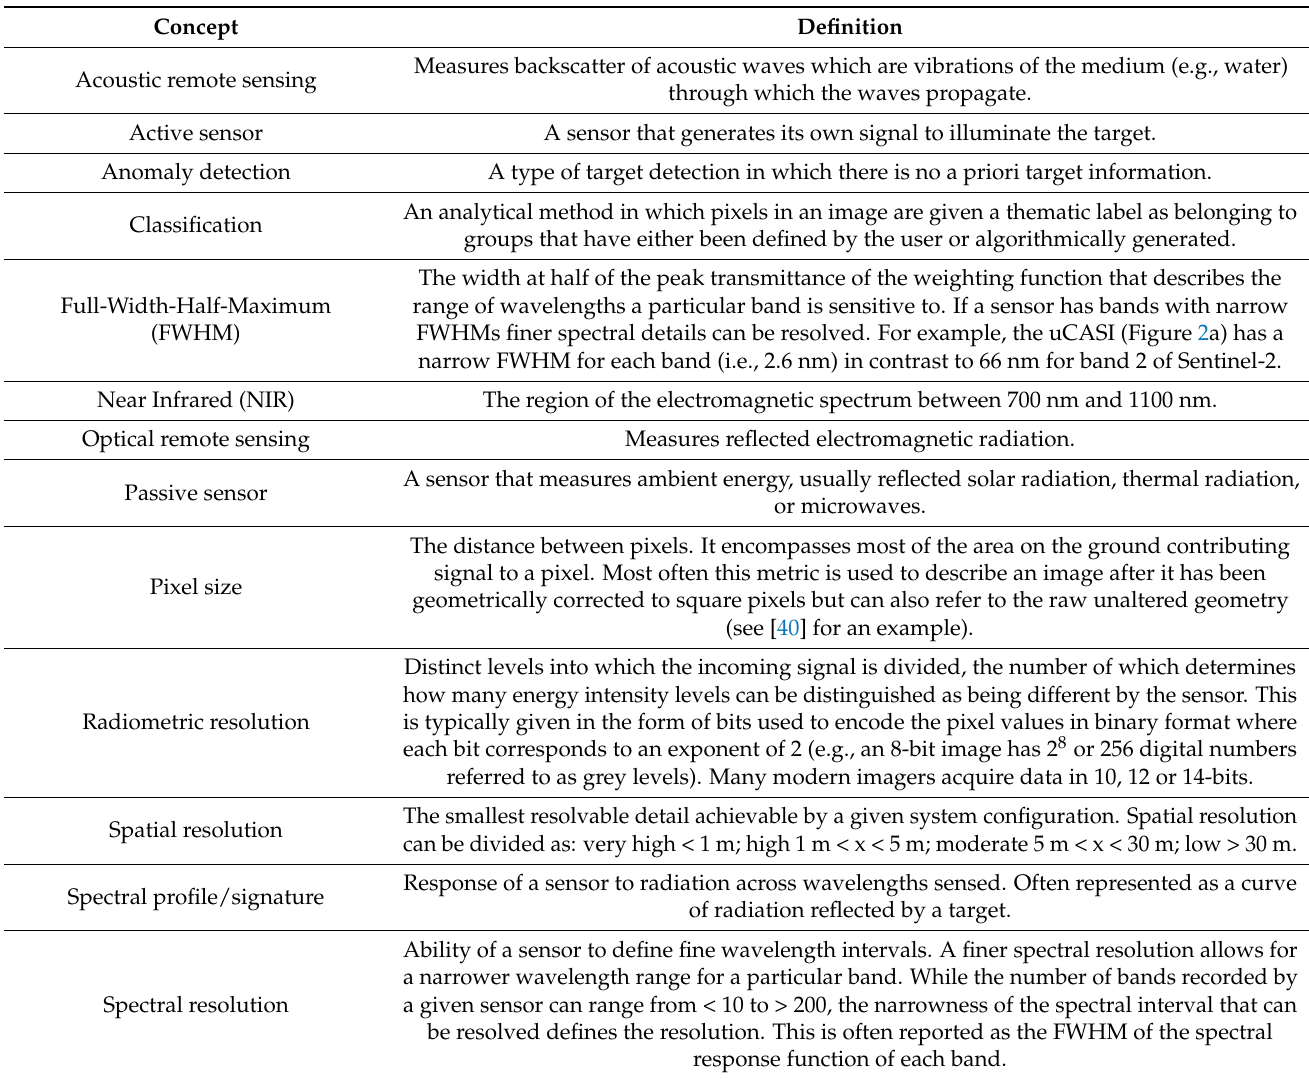
Table 1. A list of essential remote sensing concepts mentioned in this study that researchers new to remote sensing (RS) should familiarize themselves with. Readers are directed to explanatory resources such as [37–39] for further detail.